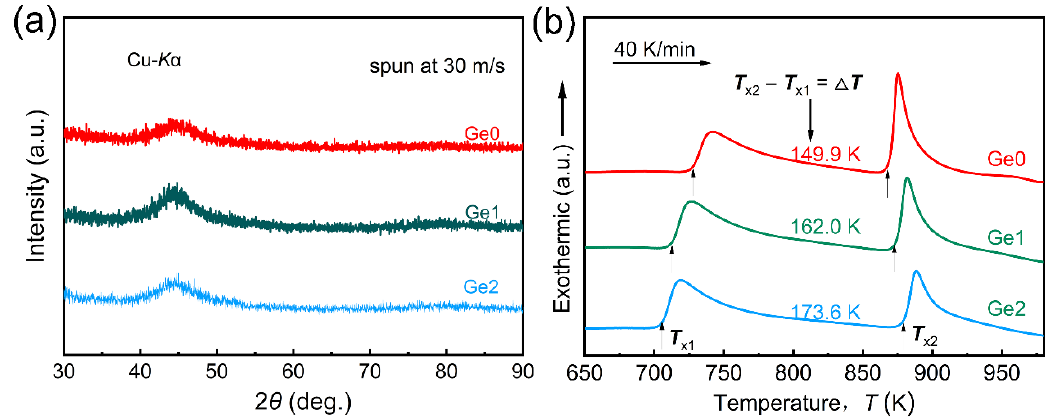
Figure 1. XRD patterns taken from the free surface ( a ) and DSC thermal scans ( b ) of the as-spun alloy ribbons.